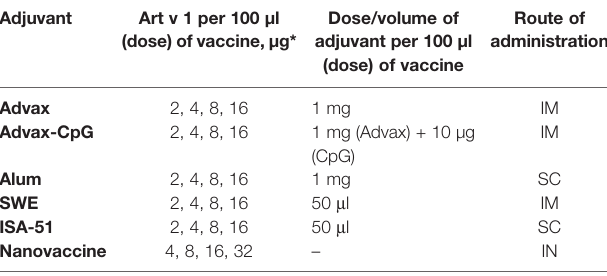
TABLE 1 | ASIT vaccine